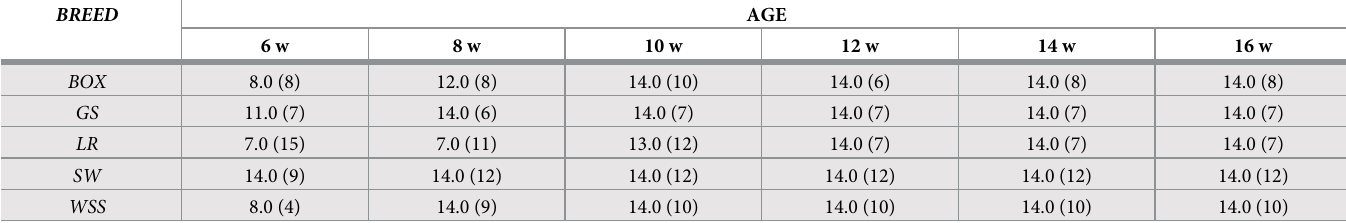
BOX = Boxer; GS = German Shepherd; LR = Labrador Retriever; SW = Saarloos Wolfdog; WSS = White Swiss Shepherd Dog. Median OC score and number of subjects (in